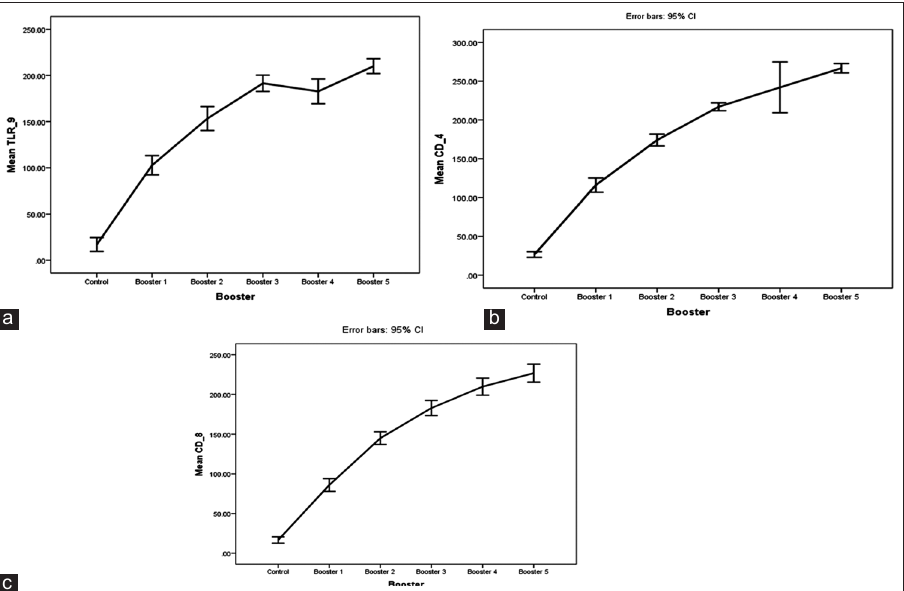
Figure-3: The amount T cells of rabbits which express toll-like receptor9 (a), CD4 (b), CD8) (c), resulted from immunization with soluble mite protein.